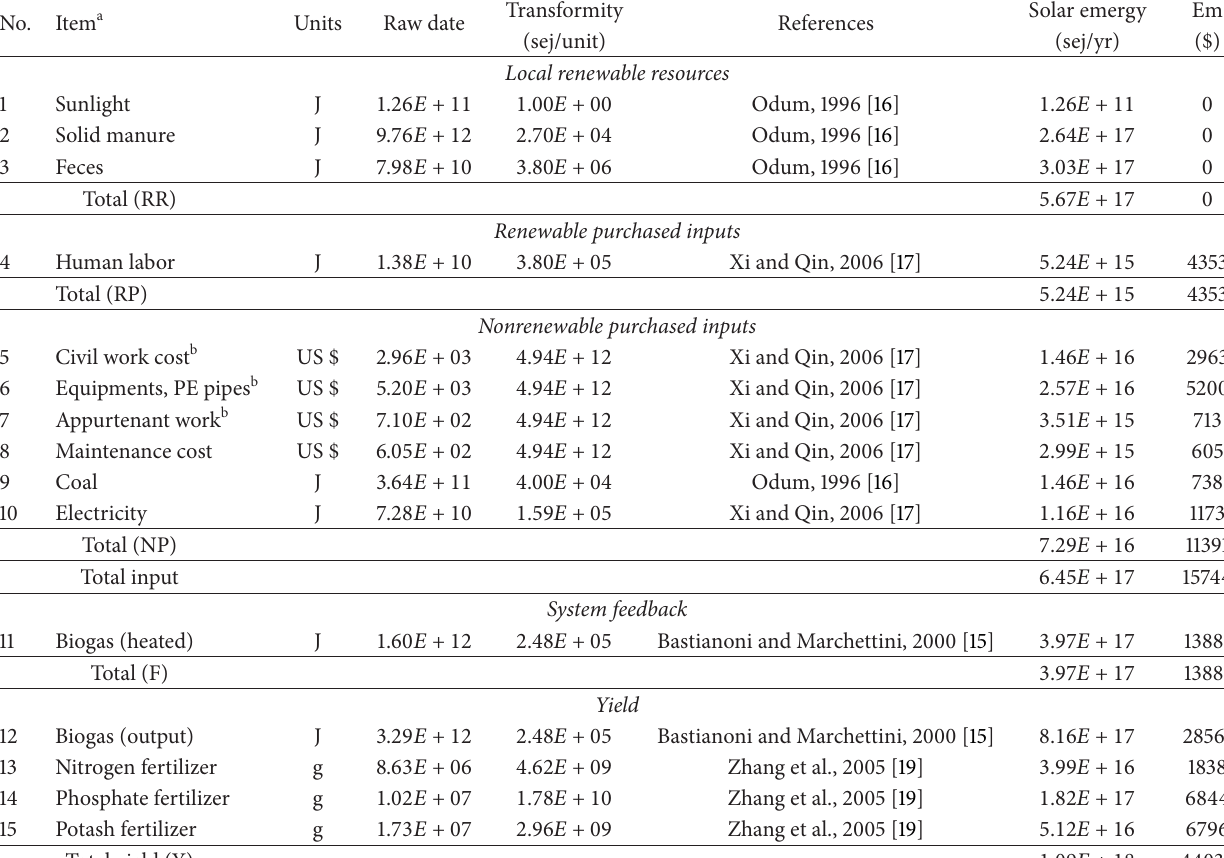
Table 2: Energy accounting for BPF system.